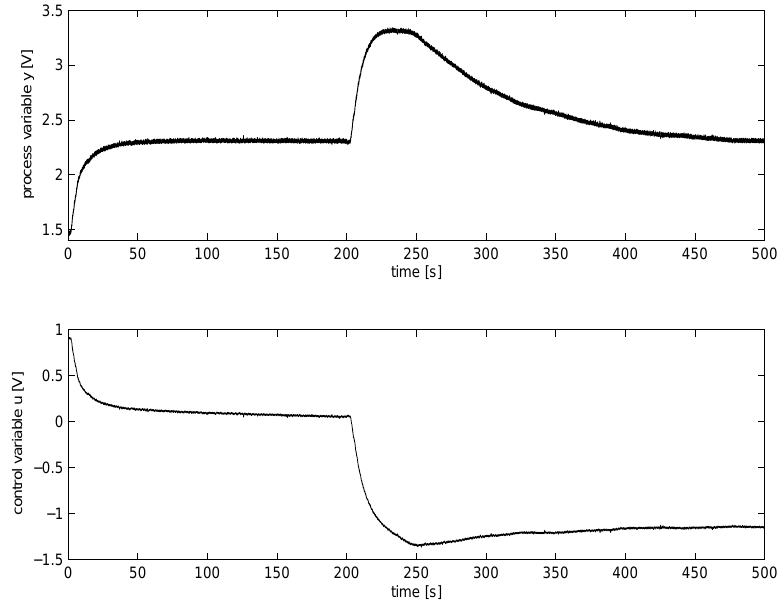
Figure 13. Experimental results for an integral process: initial tuning.